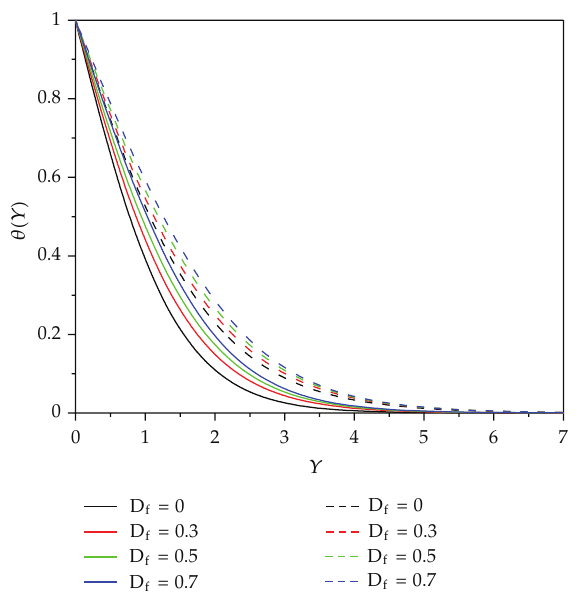
Figure 3: E ff ect of Dufour parameter D f on θ (cid:3) Y (cid:4) with Sr (cid:10) 0 . 2, λ (cid:10) − 0 . 5 (cid:3) dashed lines (cid:4) , and λ (cid:10) 0 . 5 (cid:3) solid lines (cid:4) .